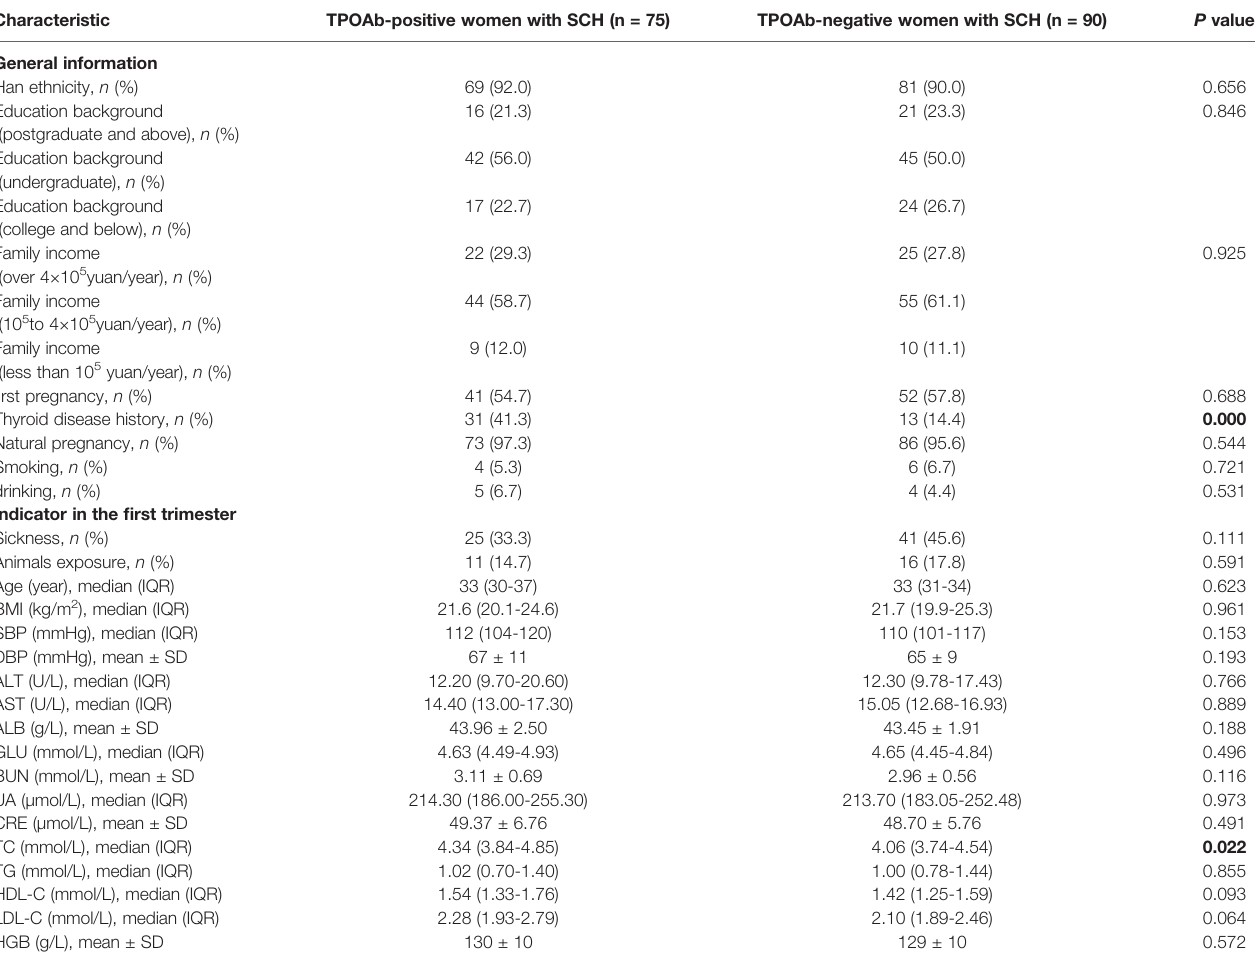
TABLE 1 | Demographic and clinical characteristics of the study participants.